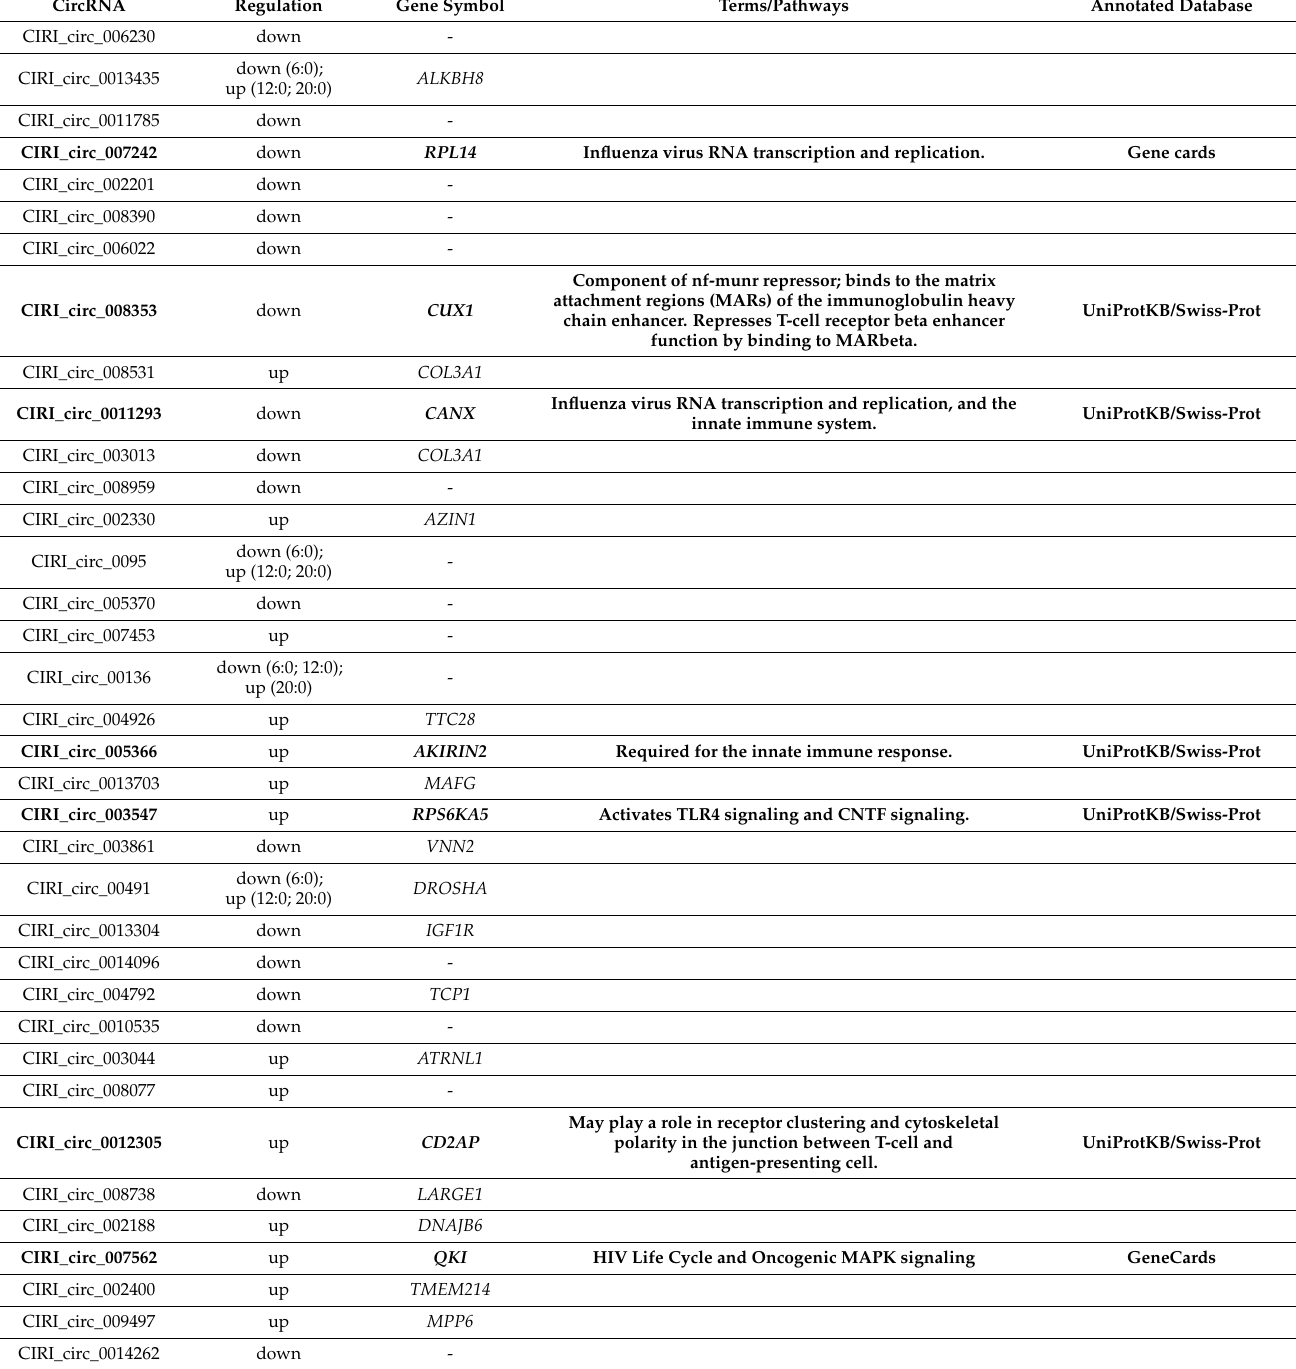
Table 1. Parental genes of the 36 common differentially expressed circRNAs. Genes relating to viral infection or immune response were annotated and highlighted in